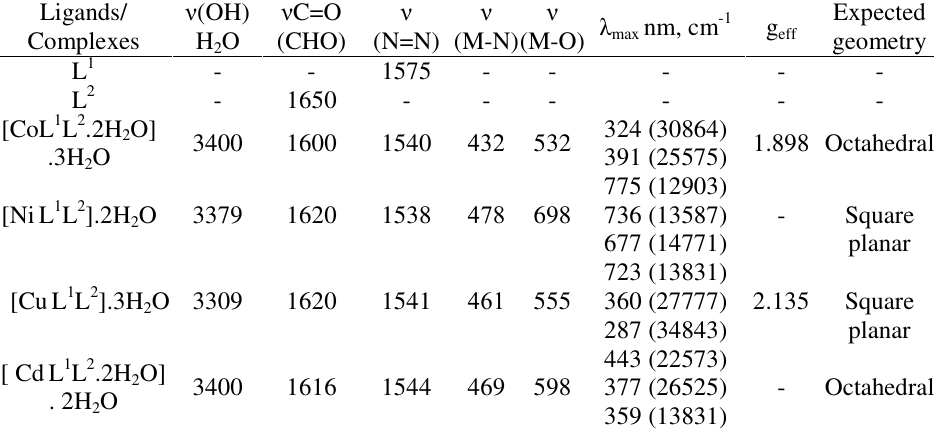
Table 2. Electron paramagnetic resonance spectra of the complexes, infrared assignments (cm -1 ) and electronic spectral data (nm, cm -1 ) of the ligands and complexes